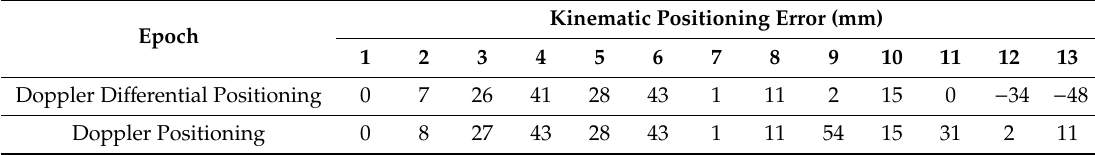
Table 3. Kinematic positioning error on a straight-line trajectory.